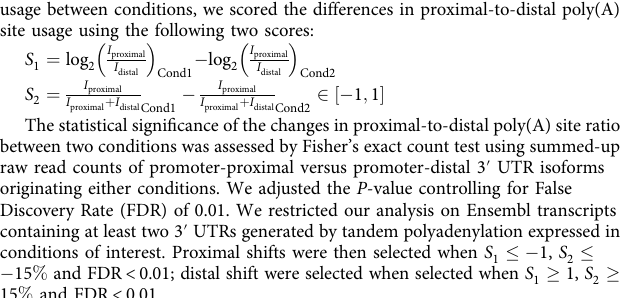
(cid:5) 1, S (cid:5) 1 2